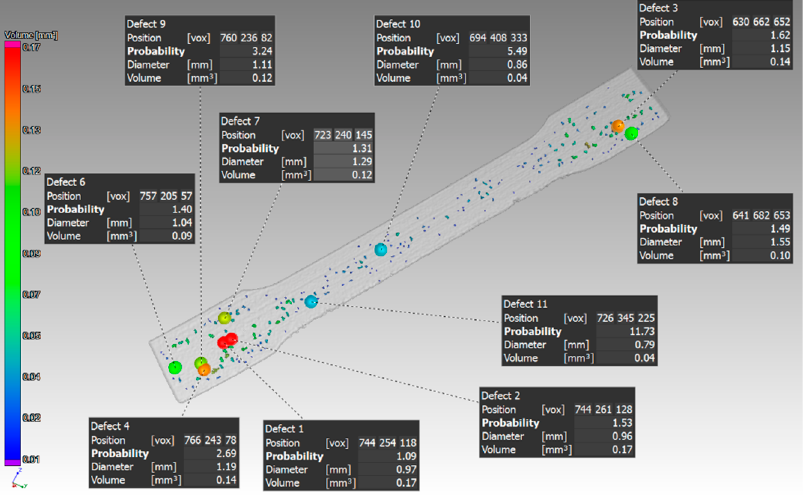
Figure 9. Specific defects evaluated in the sample, which had 1 mm thickness and was oriented XZ.